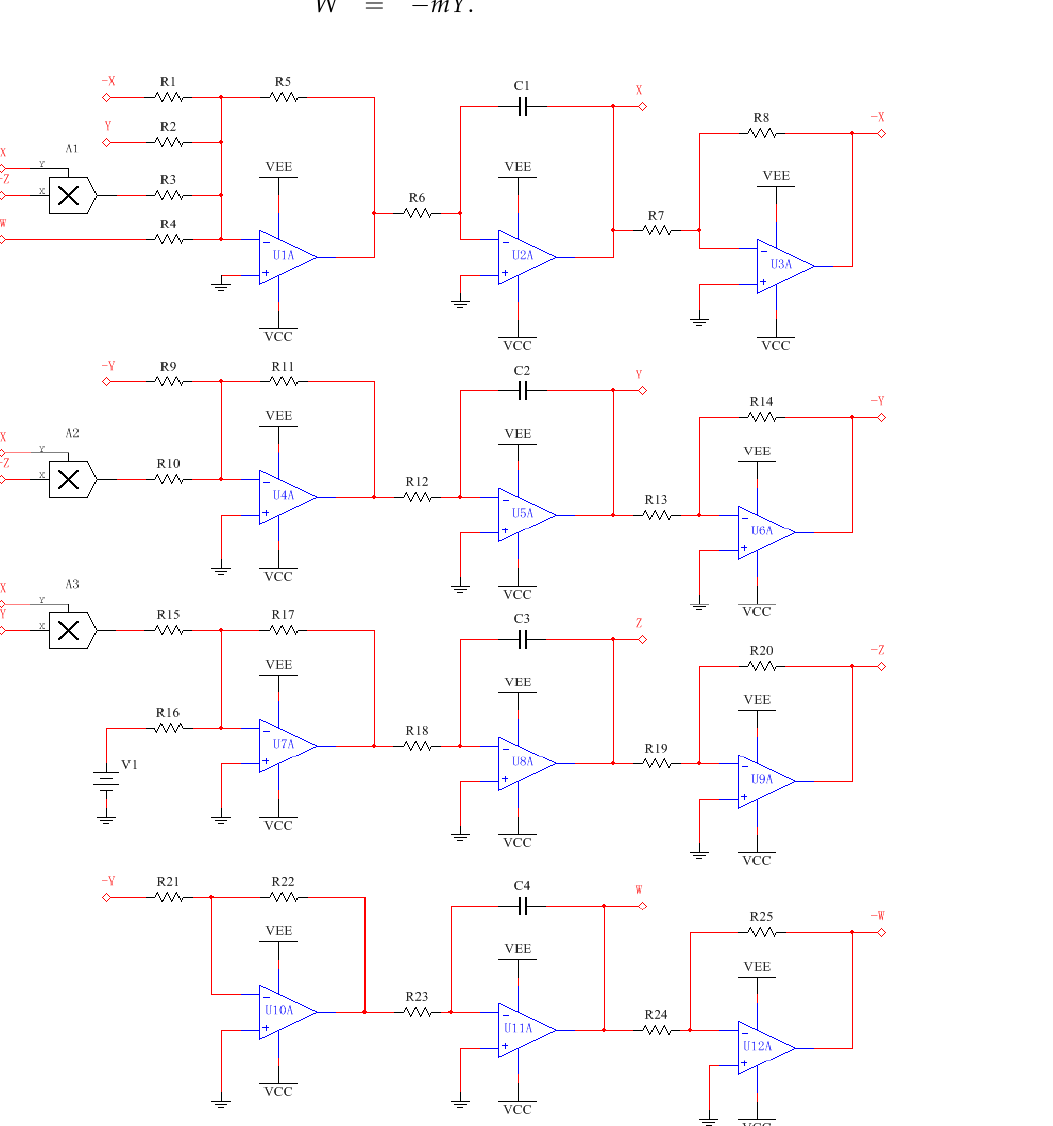
Figure 19. Circuit diagram of the implementation of system